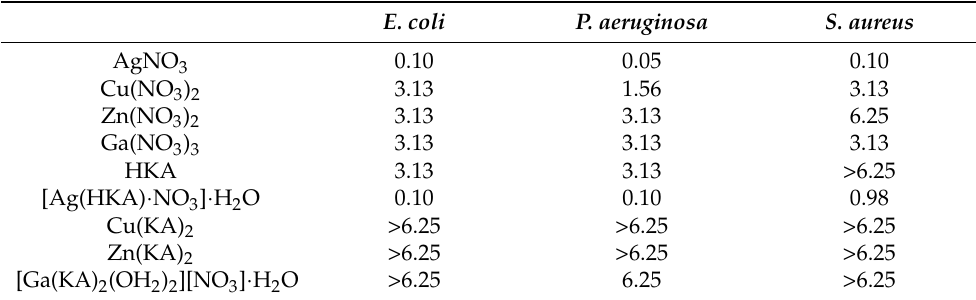
Table 2. Minimum biocidal concentrations (MBCs) as evaluated by regrowth in both broth and agar media